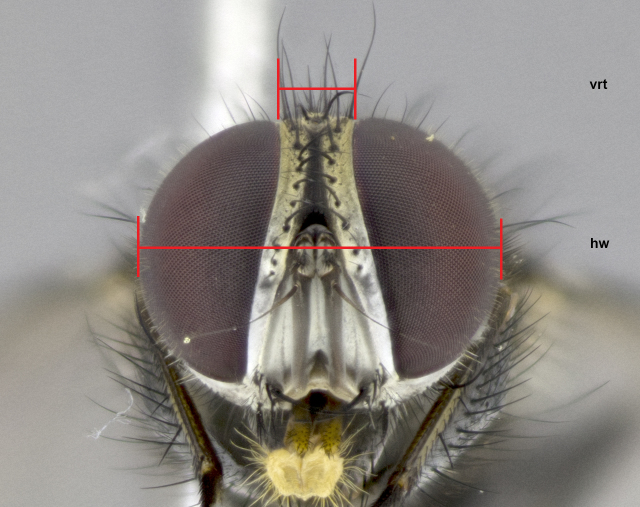
Sample of measured areas from front of head as shown on Hyphantrophaga
virilis (Aldrich & Webber, 1924); vrt, vertex; hw, head width